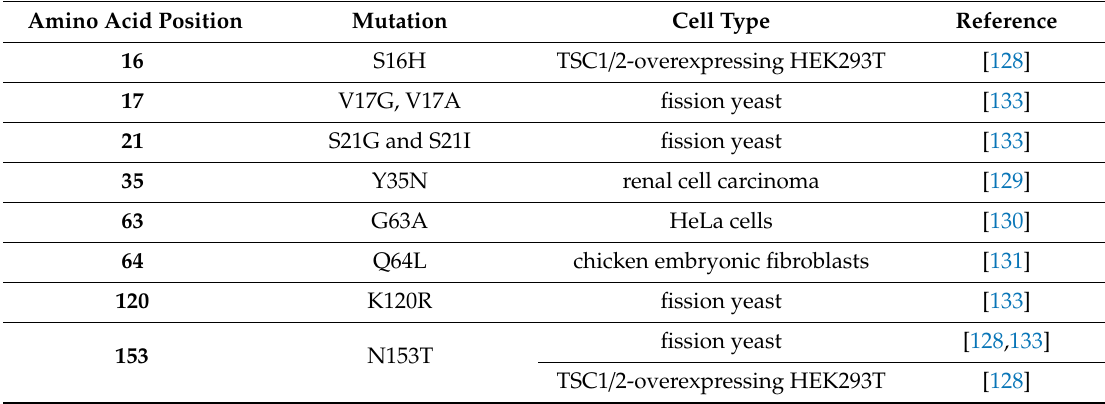
Table 1. List of mutations associated with the constitutive activation of